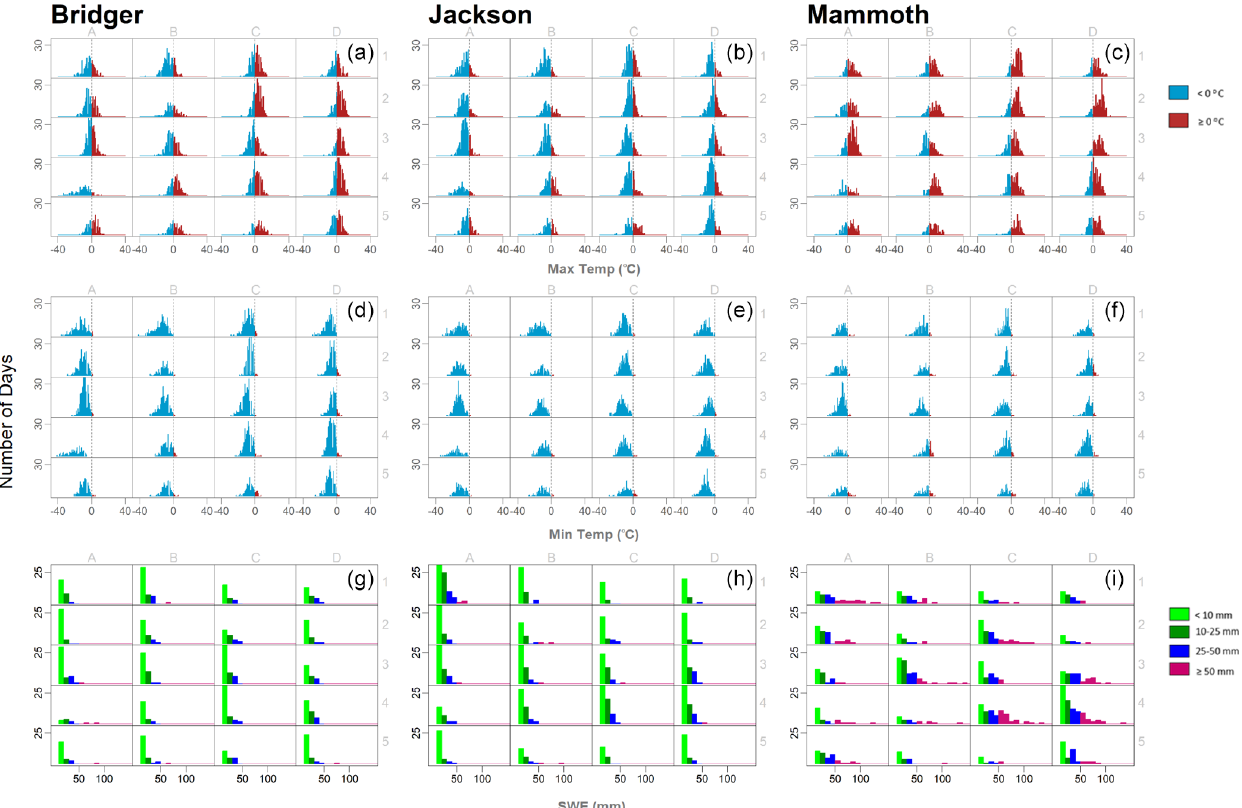
Figure 3. Histograms of daily maximum temperature (a–c) , minimum temperature (d–f) , and snow water equivalence totals (g–i) for Bridger Bowl (a, d, g) , Jackson (b, e, h) , and Mammoth Mountain (c, f, i) . For each of the nine arrays, the position of the plot corresponds with the map pattern shown in Figs. 2 and 3. For example, the histograms located in the upper left corner of each array correspond with synoptic type